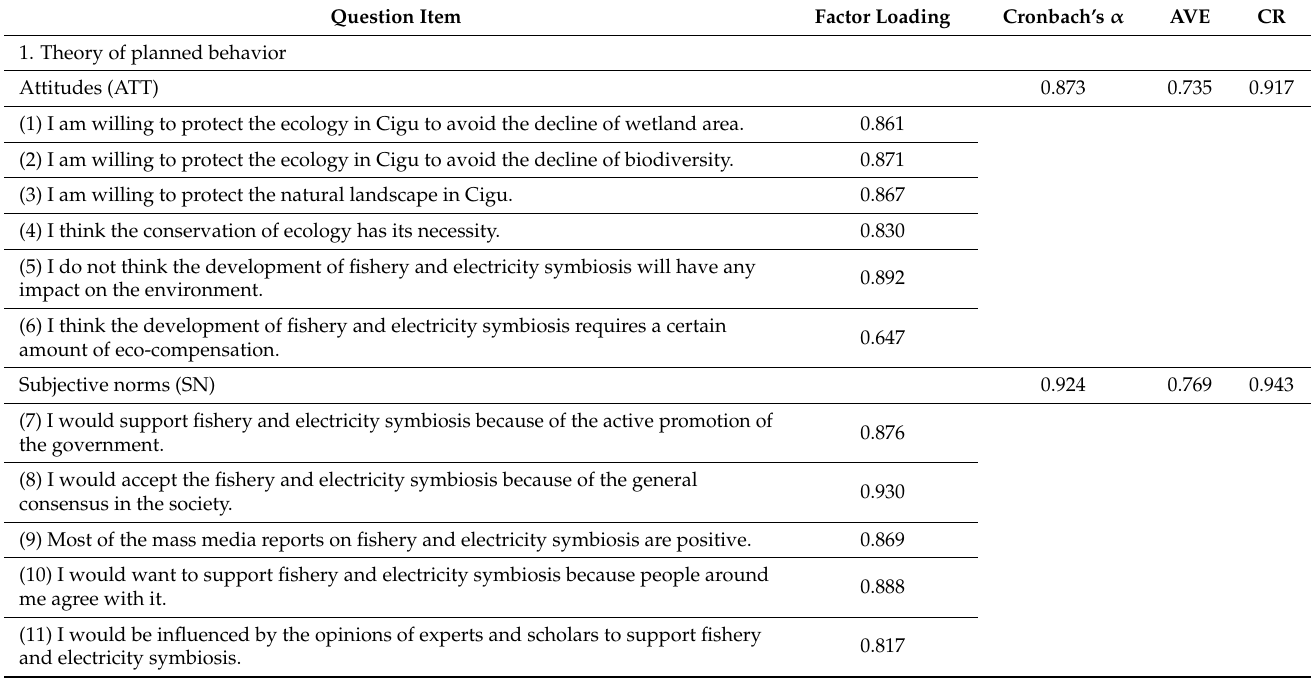
Table 1. Results of the factor loading, reliability, and